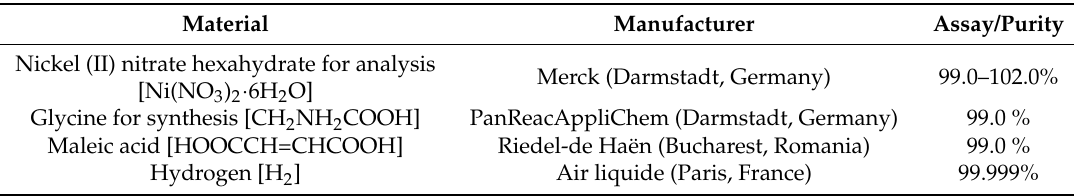
Table 1. Materials used for SCS catalysts production and the hydrogenation